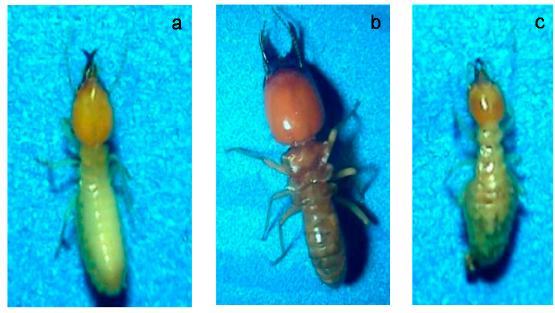
Figure 2. Termites found at the research locations: ( a ) C. curvignathus ; ( b ) M. gilvus ; ( c ) M. insperatus .